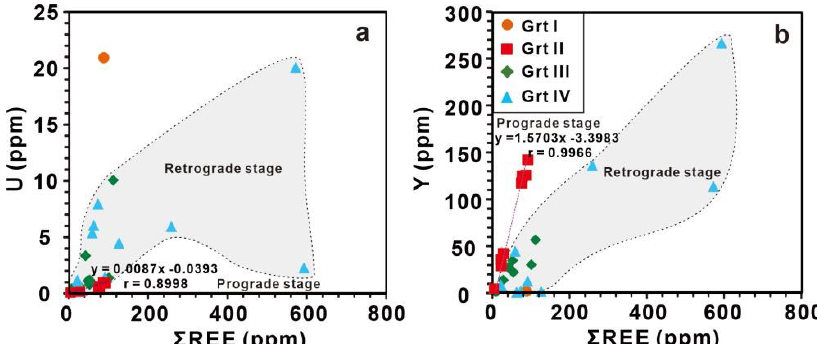
Figure 12. ( a ) Total REE concentrations (∑ REE) versus total Al in atoms per formula unit (apfu) for garnets from the Huanggang deposit. ( b ) ∑ REE versus percentage of the andradite (adr) end-mem- ber component in garnets. ( c ) LREE/HREE fractionation versus Fe 3+ /(Fe 3+ + Al) ratio of garnets. ( d ) Eu anomaly (δEu) versus Fe 3+ /(Fe 3+ + Al) ratio of garnets.